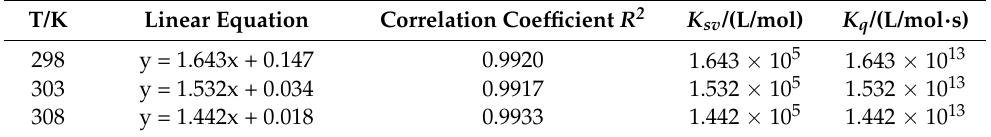
Table 1. Quenching constants for the interaction of TRP and MC at different temperatures.